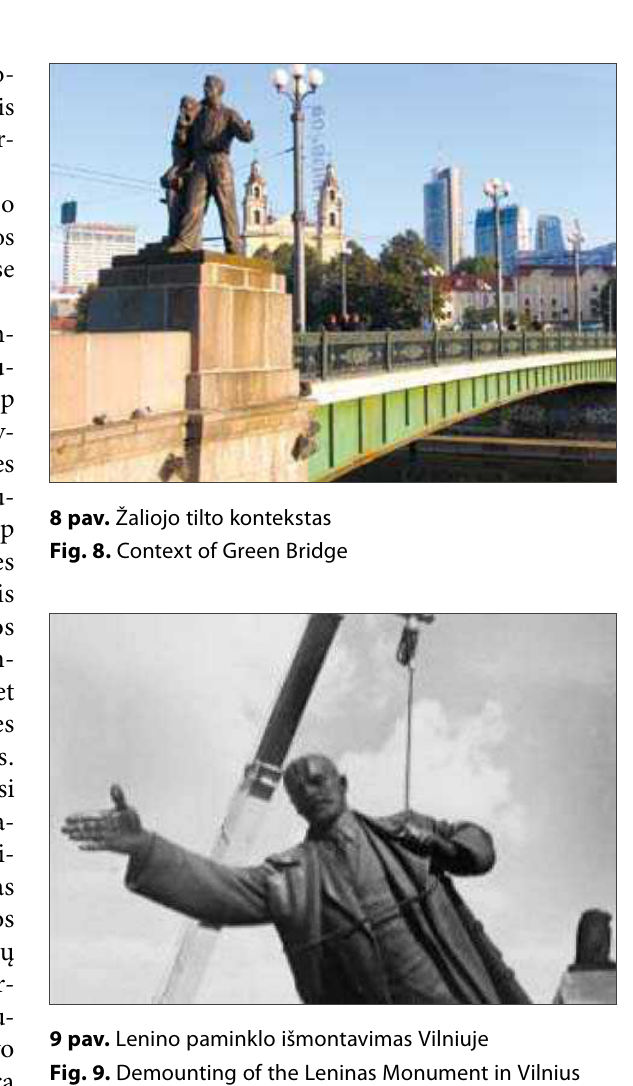
Fig. 9. Demounting of the Leninas Monument in Vilnius